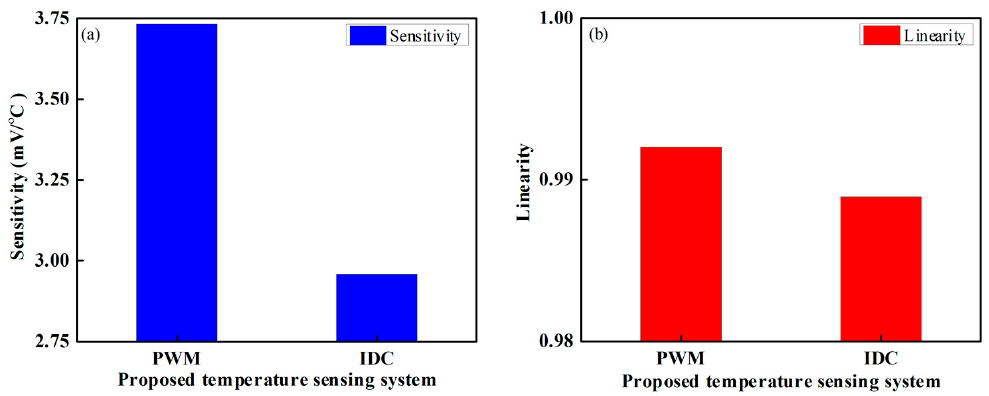
Figure 11. Graphical representation of the proposed fiber-optic PWM and IDC temperature sensing system: ( a ) Sensitivity and ( b ) Linearity.